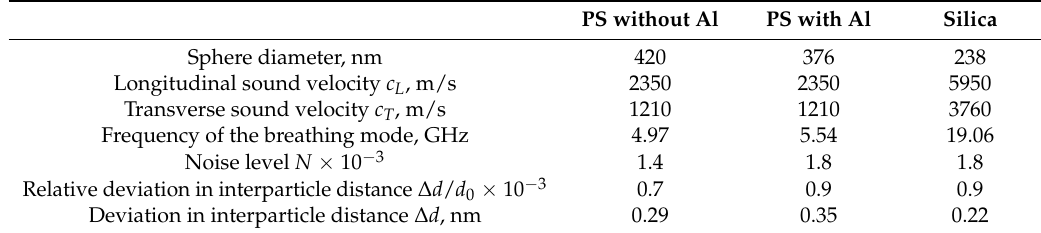
Table 1. Parameters of PS and silica nanoparticles used in our model. The corresponding frequencies of the first spheroidal mode of colloidal particles were obtained from reference [30]. The noise level was derived from the experimental data. Relative and absolute deviation in the interparticle distance ( ∆ d / d 0 and ∆ d ), which could be detected in our experiment with the probability of 60%, were calculated from the experimental data and simulations. PS without Al PS with Al Silica Sphere diameter, nm 420 376 238 Longitudinal sound velocity c L , m/s 2350 2350 5950 Transverse sound velocity c T , m/s 1210 1210 3760 Frequency of the breathing mode, GHz 4.97 5.54